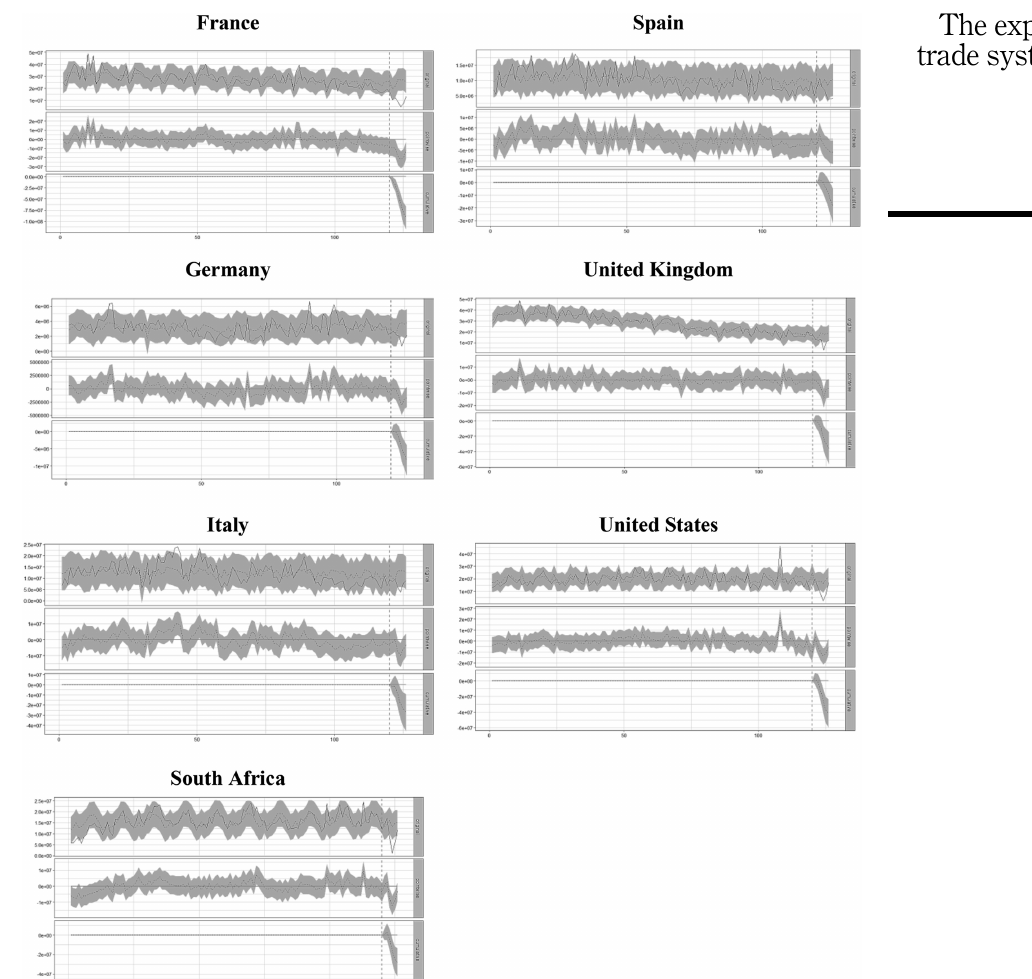
Figure A4. Bayesian posterior distribution graphs for the impact of COVID-19 pandemic on export trading